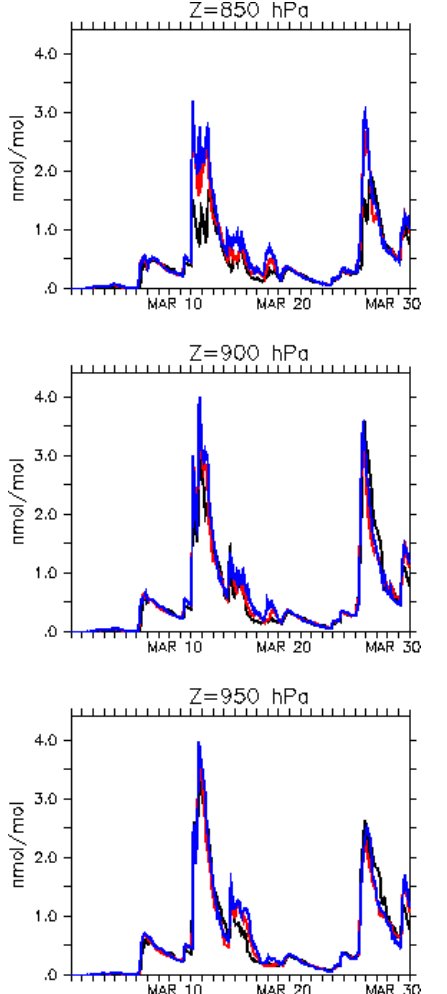
Fig. 10. Maximum mixing ratio (nmol/mol) of tracer VOL. The maximum is calculated in a rectangle ranging from 5 ◦ W to 25 ◦ E and 36 ◦ to 56 ◦ N. The mixing ratios are displayed at three different pressure levels: 750, 800 and 850 hPa. The injection height is 800 hPa. The ECHAM5/MESSy result is displayed in black. The red and the blue lines show the maximum mixing ratios of the COSMO-40 and COSMO-7 domains, respectively.